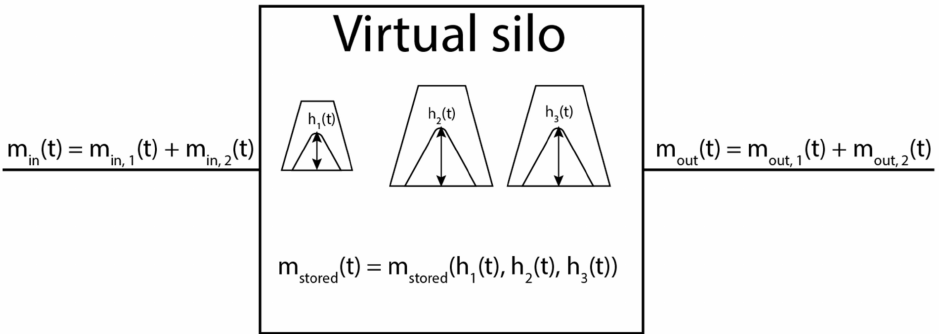
Figure 6. The defined virtual silo with a time-dependent mass inflow, mass outflow, and stored mass dependent on the time-dependent ore heights in the